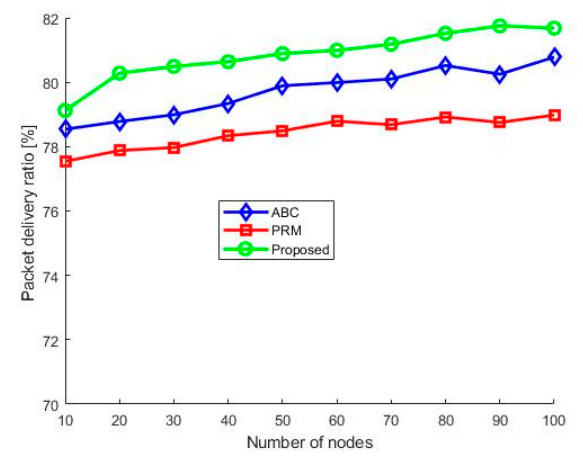
Figure 10. Packet delivery ratio.